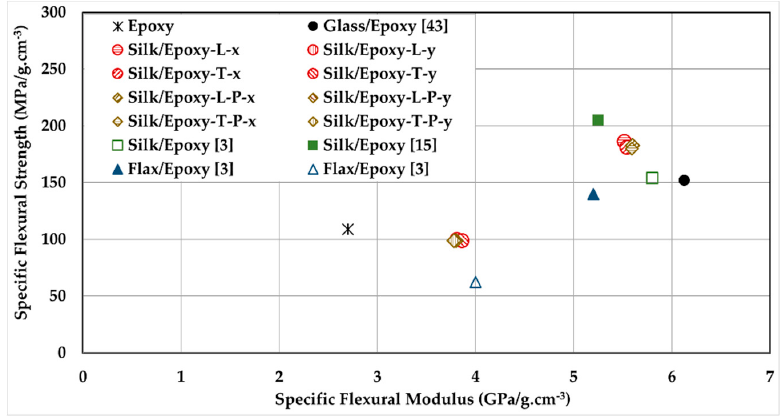
Figure 7. Specific flexural properties of silk/epoxy laminates compared to glass/epoxy laminates and neat epoxy samples, as well as reported properties for silk/epoxy and flax/epoxy from the literature.